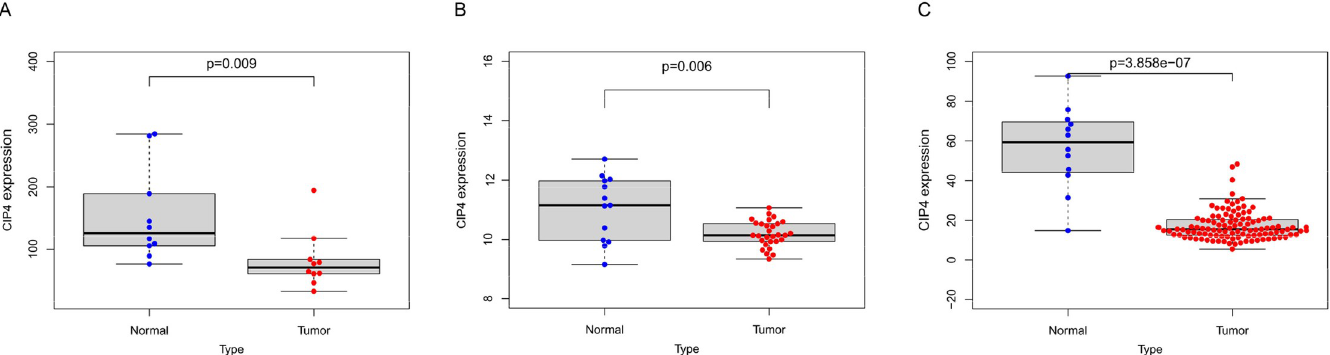
Fig 1. The expression levels of CIP4 between tumor and non-tumor samples in LC patients. (A) GSE51985; (B) GSE59102; (C) TCGA database.